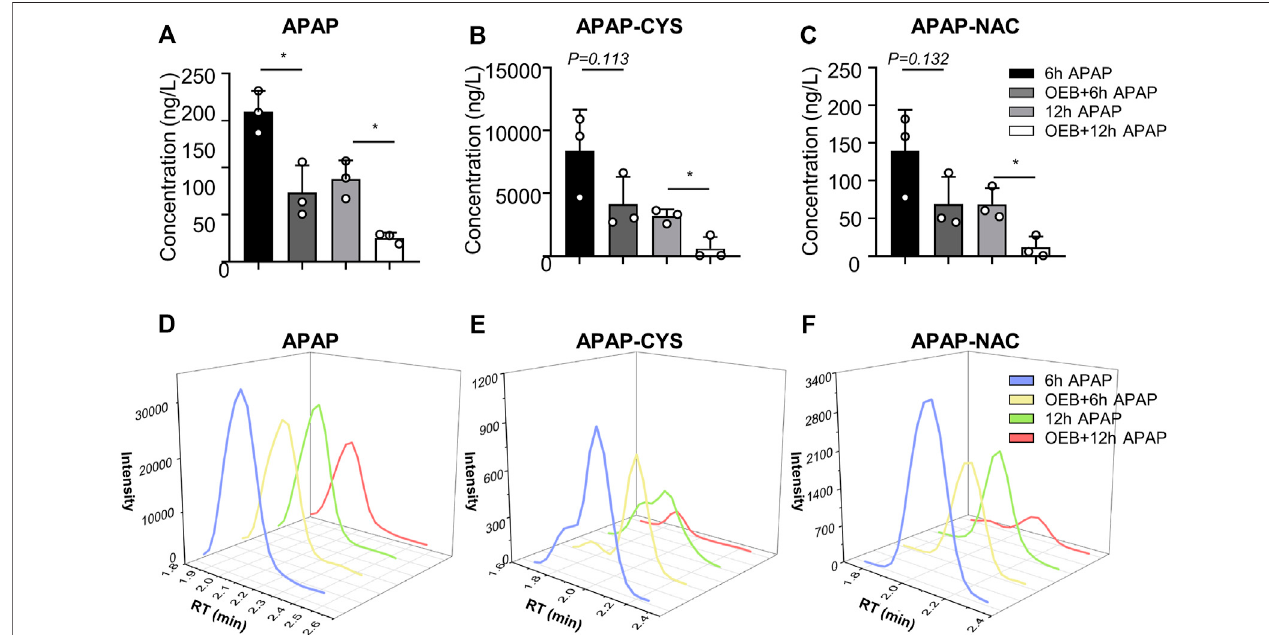
FIGURE 2 | OEB reduced APAP-induced hepatotoxicity through regulating APAP-metabolism. (A) APAP content, (B) APAP-CYS content and (C) APAP-NAC contentinmiceserum,weremeasuredbyHPLC-MS/MSafteradministeringAPAP6 hand12 h( n =3).Intensitiesof (D) APAP, (E) APAP-CYSand (F) APAP-NACwere analyzed by HPLC-MS/MS. * p < 0.05 versus APAP-treated group.